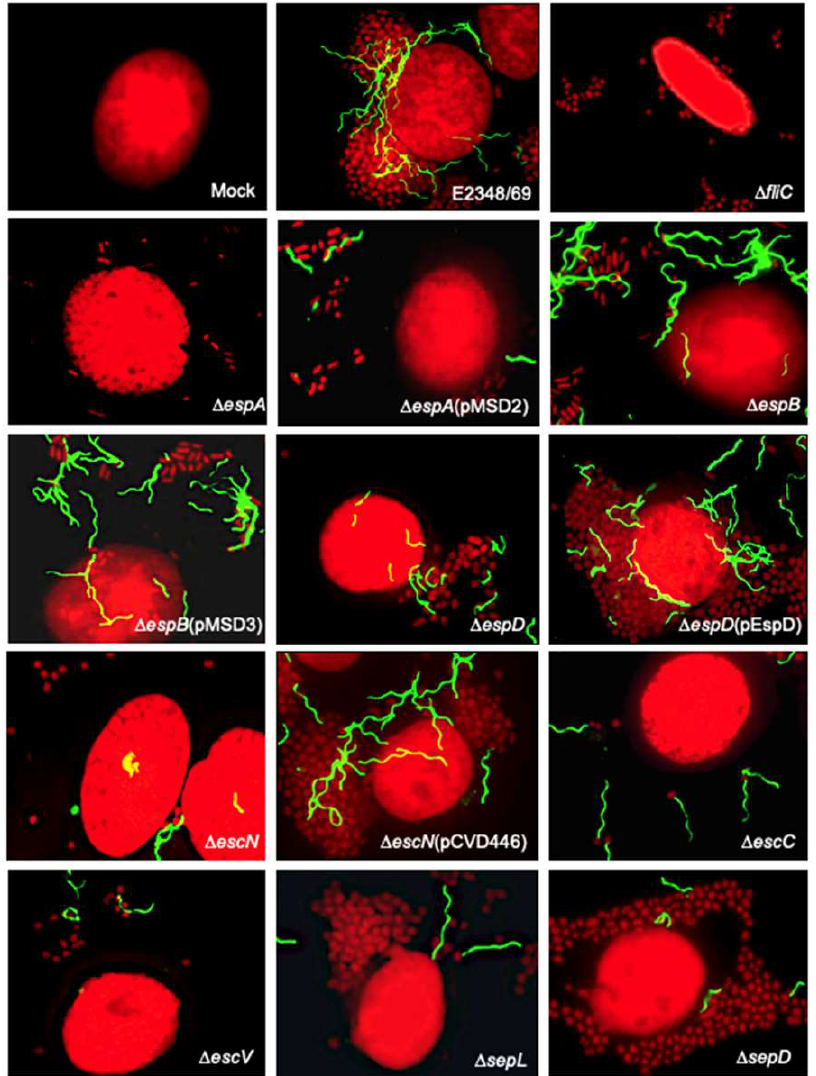
Figure 3. Visualization of flagella by DMEM-grown EPEC strains adhering to HeLa cells. Flagella (green) produced by the indicated bacterial strains adhering to HeLa cells were visualized by im- munofluorescence using rabbit anti-H6 flagella antibodies and anti-rabbit IgG Alexa-fluor 488. The cellular and bacterial DNA was stained with propidium iodide (red). Immunofluorescence images were taken at 60×.